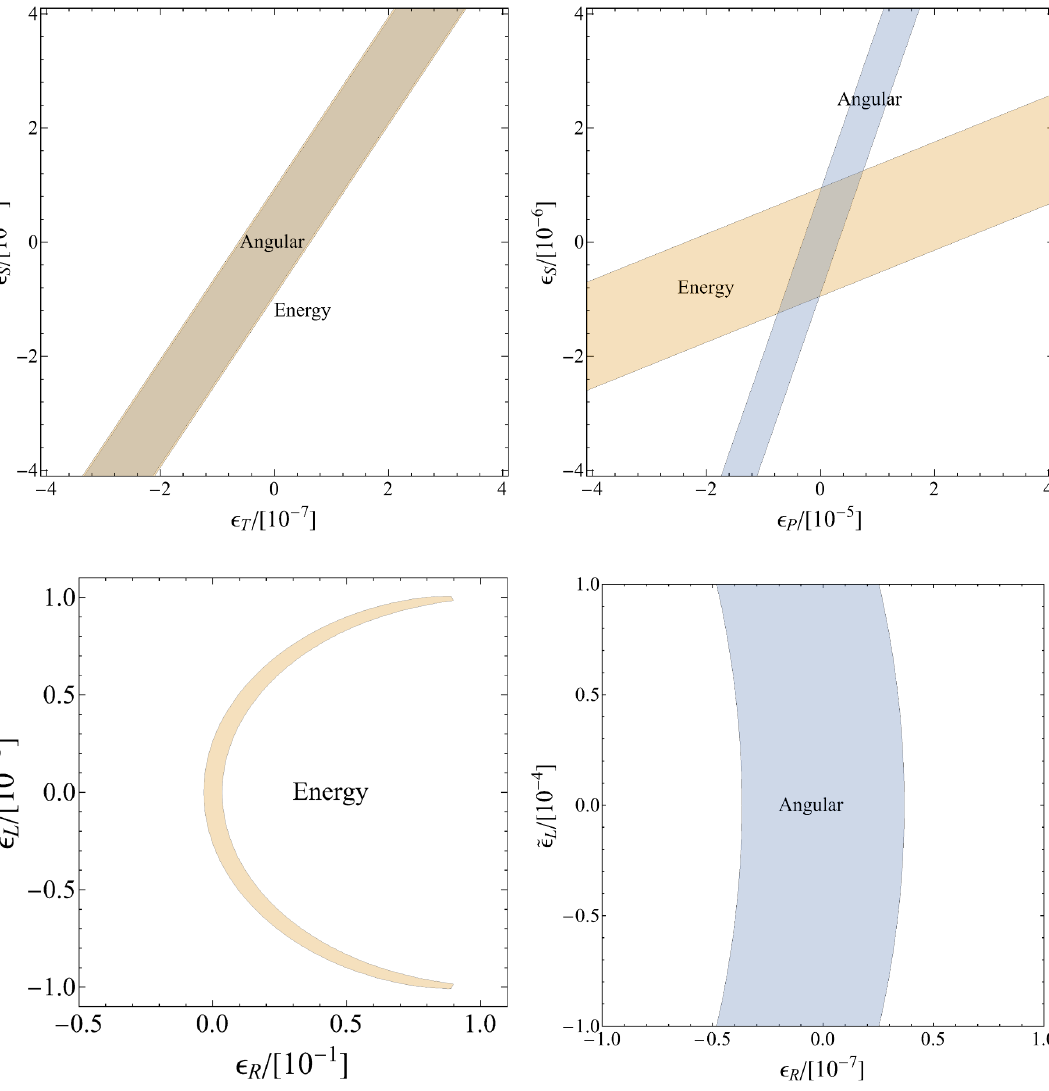
Figure 10 . 95 % CL regions for BSM contributions driven by two exotic currents for N tot = 10 18 events. The region based on the energy (angular) distribution is in orange (blue). The combinations of currents are: scalar and tensor (top left), scalar and pseudoscalar (top right), right-handed hadronic and right-handed leptonic (bottom, left for energy and right for